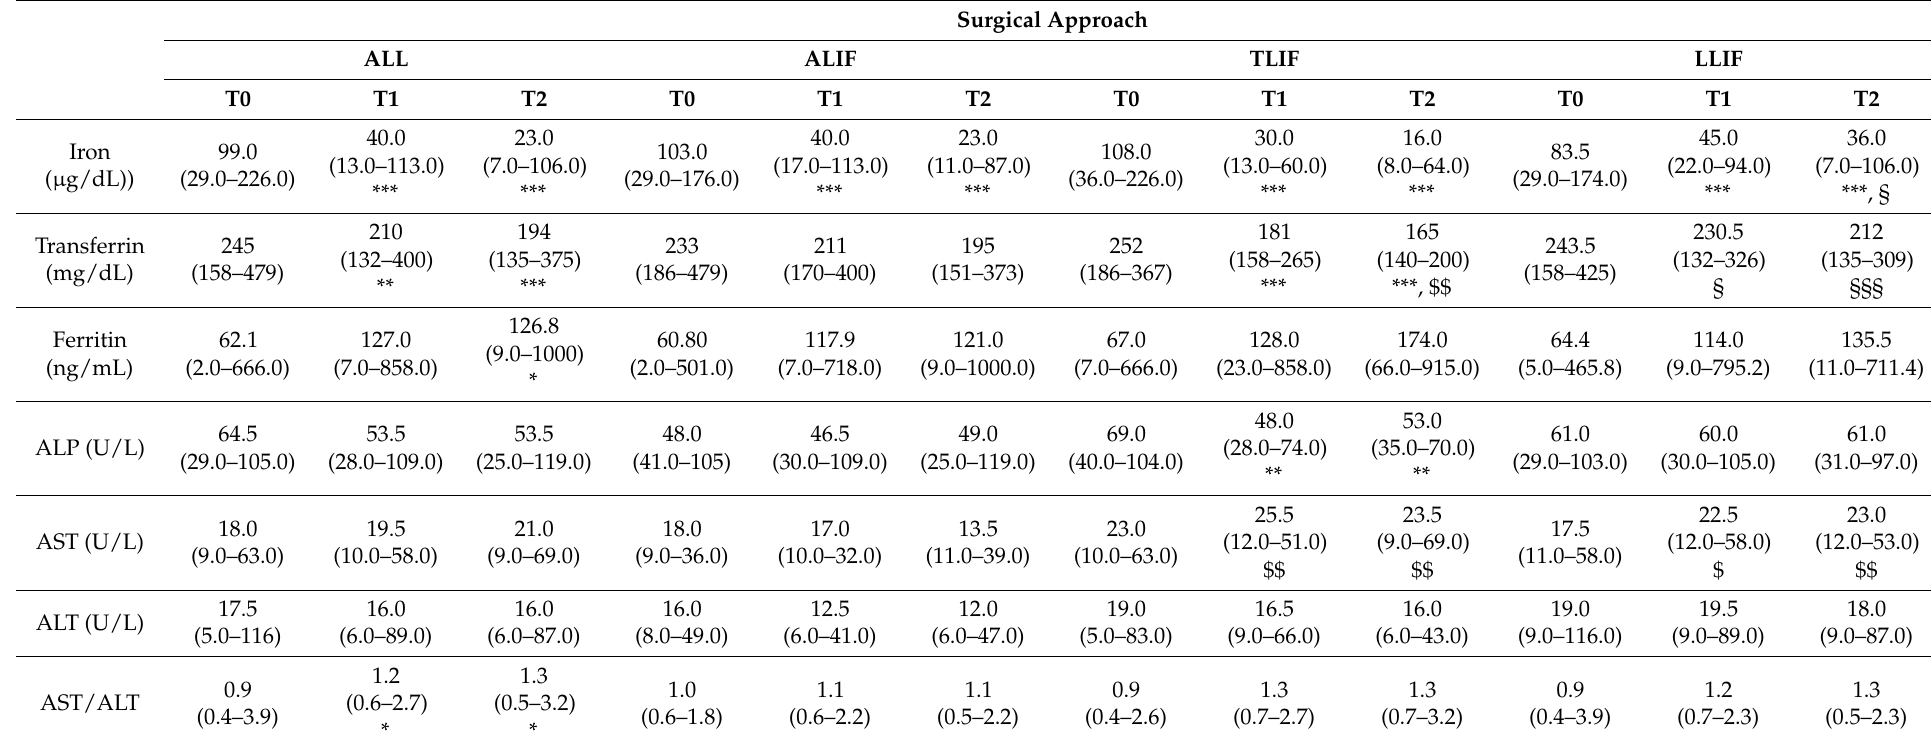
Table 2. Clinical chemistry parameters over the peri-surgical period. Surgical